Question: Which visualization type does this figure use?
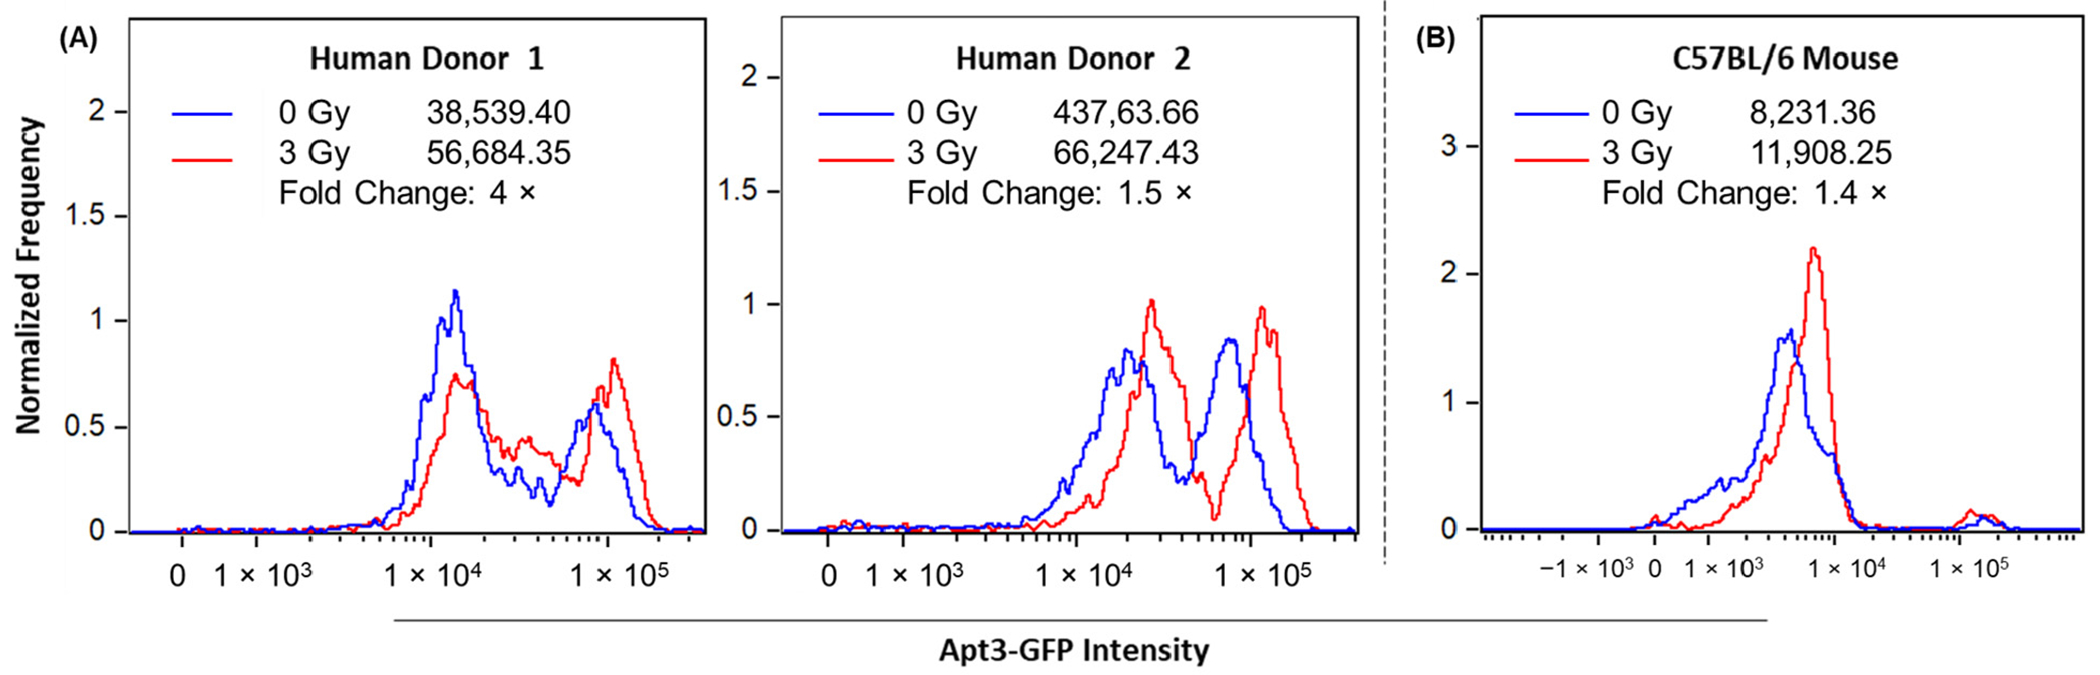
Answer: histogram